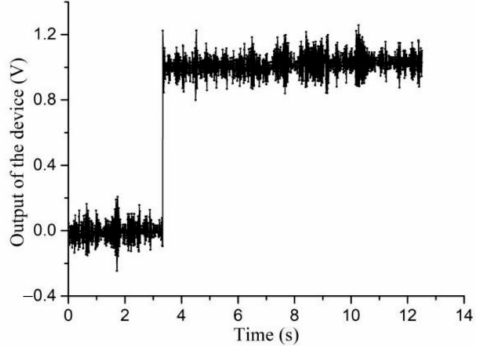
Figure 7. The output of the VP tiltmeter without feedback.